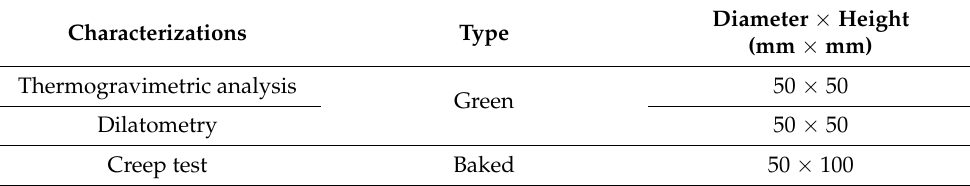
Table 2. Sample dimensions for different characterizations.